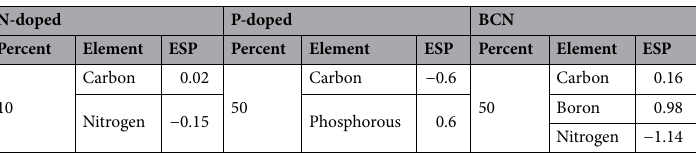
N-doped P-doped BCN Element ESP Percent